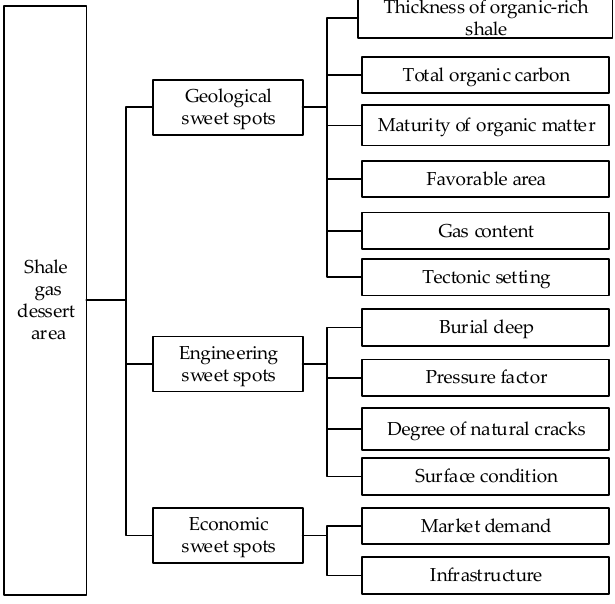
Figure 5. Causality analysis of the evaluation model for shale-gas sweet spots.